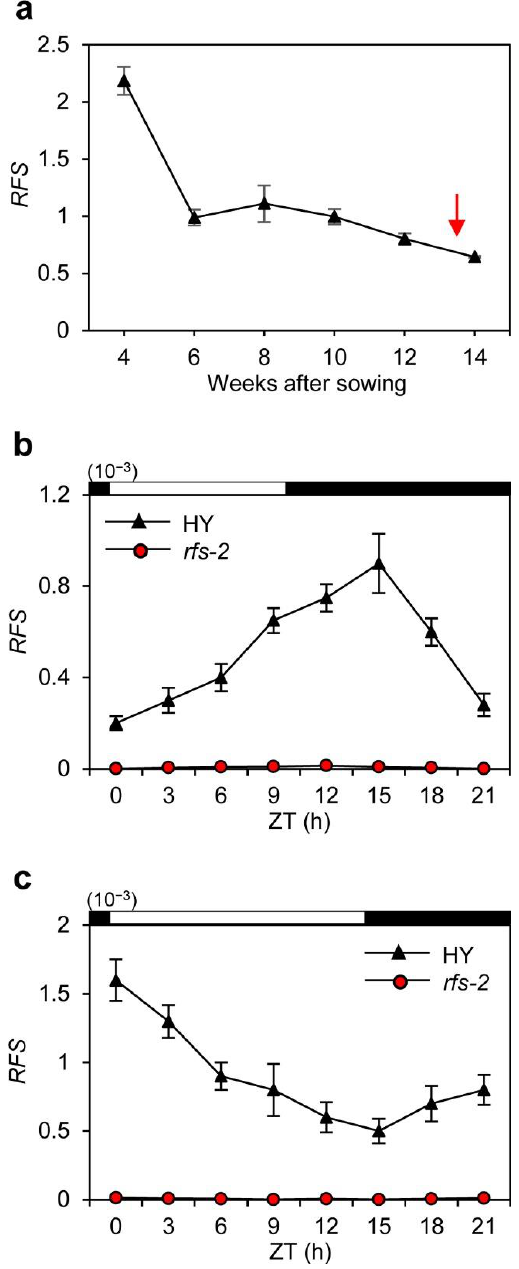
Figure 2. Expression profile of RFS . ( a ) Expression levels of RFS during plant development in HY under LD conditions. Total RNA was isolated from the leaves harvested every 2 weeks from 4 weeks after sowing (WAS) to 14 WAS at ZT1. The red arrow indicates the average flowering date of HY. ( b , c ) Diurnal change of RFS expression in HY and rfs-2 plants under SD ( b ) and LD ( c ) con- ditions. Total RNA was extracted from HY and rfs-2 leaf blades harvested every 3 h during a 24-h period from plants at 25 days after sowing (DAS) in SDs and 80 DAS in LDs. The open and filled bars at the top of graphs represent light and dark periods, respectively. Transcript levels of RFS were determined by RT-qPCR and normalized to that of OsUBQ5 ( LOC_Os01g22490 ). Means and standard deviations were obtained from three biological replicates. Experiments were repeated three times with similar results. ZT, zeitgeber time (hours after dawn).